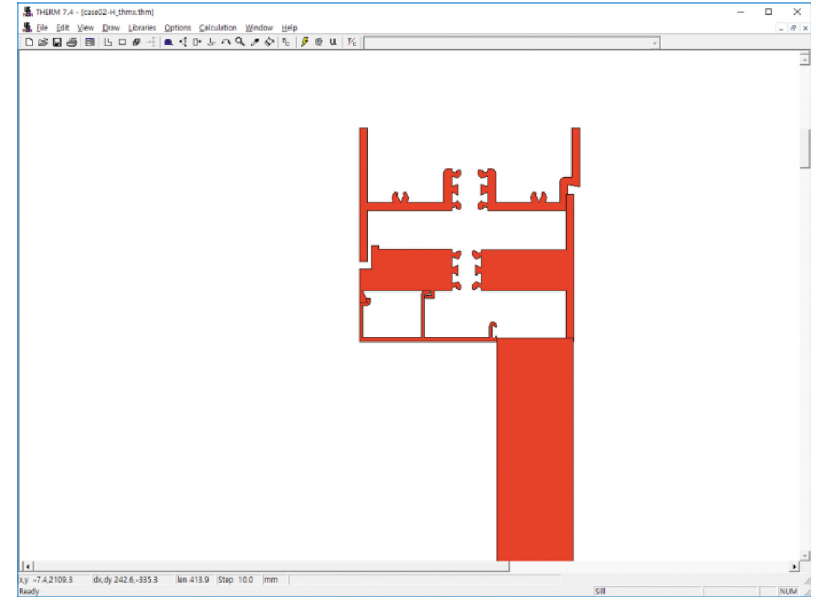
Figure 13: THERM input result (head) of test case